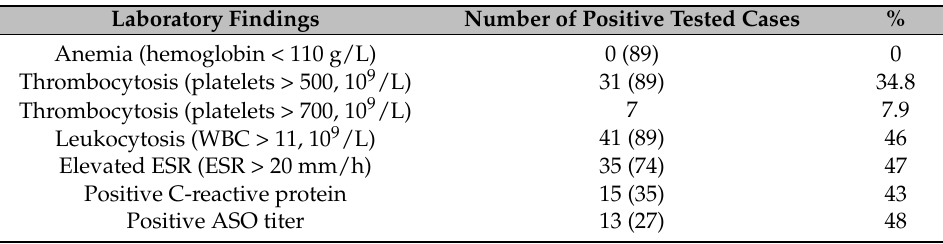
Table 3. Laboratory findings in 89 children with IgA